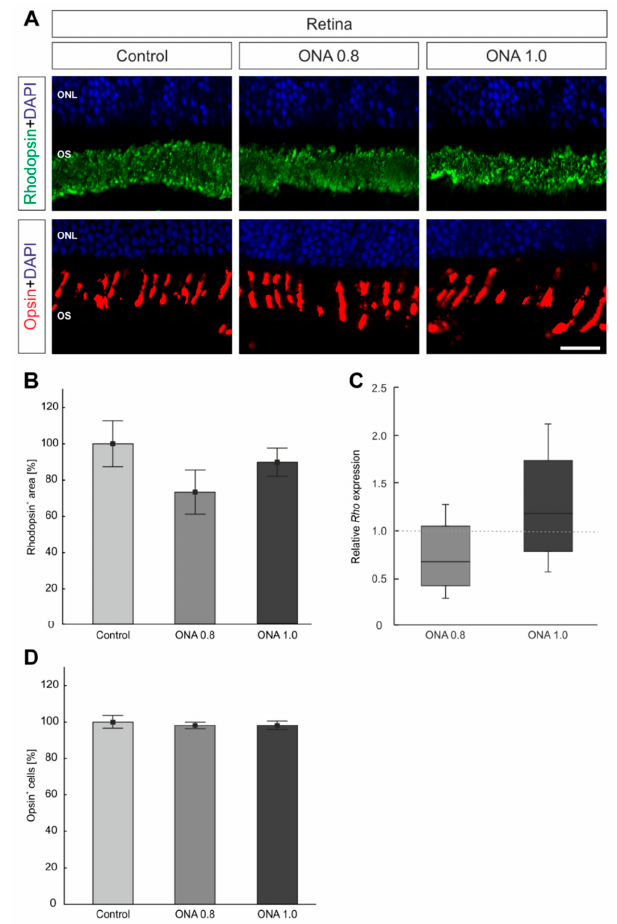
Figure 2. No photoreceptor degeneration. ( A ) Retinas were stained with antibodies against anti-rhodopsin (rods; green) and anti-opsin (cones; red). Cell nuclei were marked in